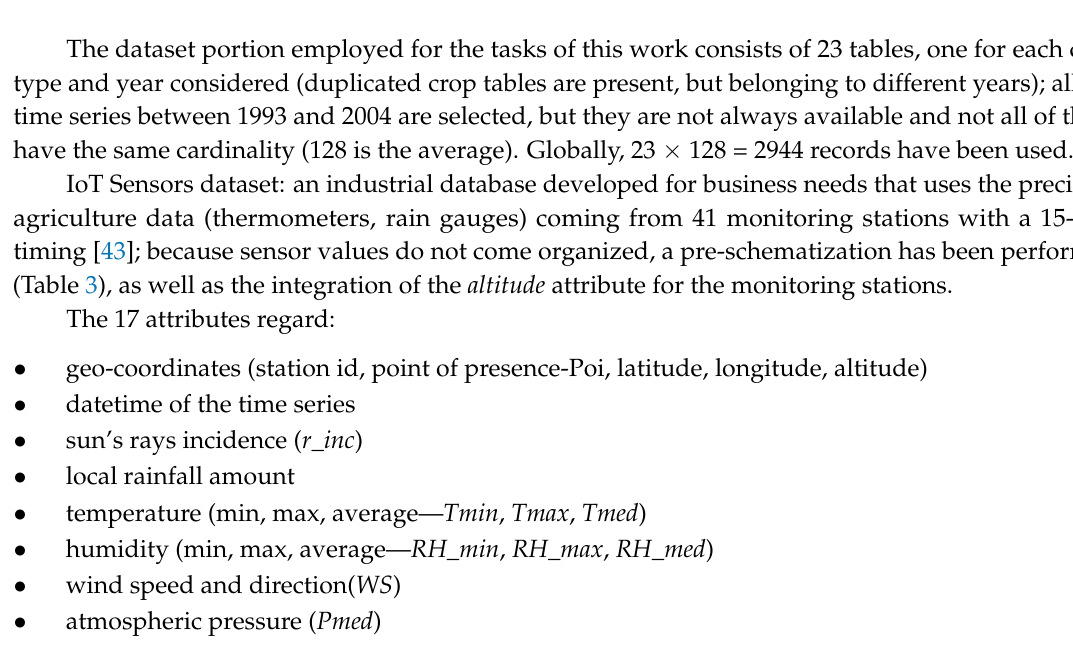
Table 3. Details of the Internet of Things (IoT) sensors